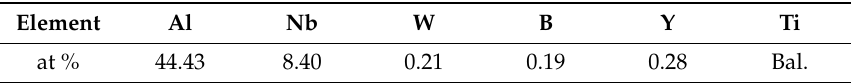
Table 1. Chemical composition of present TiAl alloy.